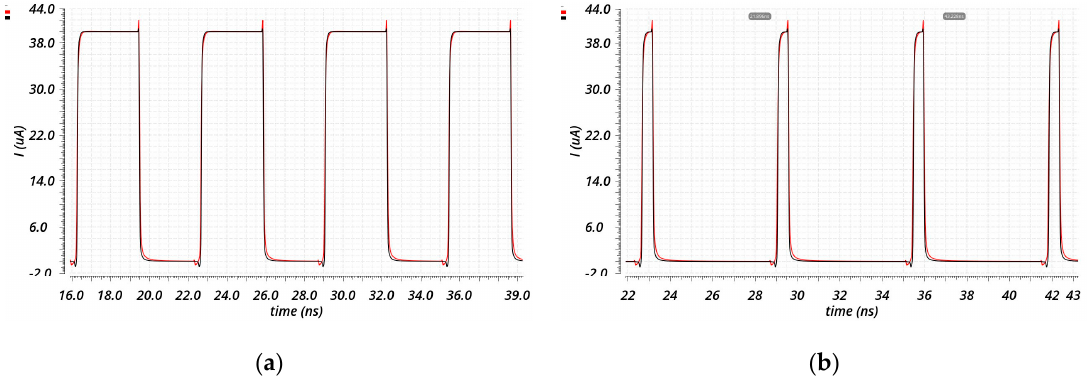
Figure 10. Transient behavior of the CP of Figure 9. The source current is in red, and the sink current is in black for two different values of ON time of the input signals (UP and DW_N): ( a ) 3.2 ns, ( b ) 500 ps.